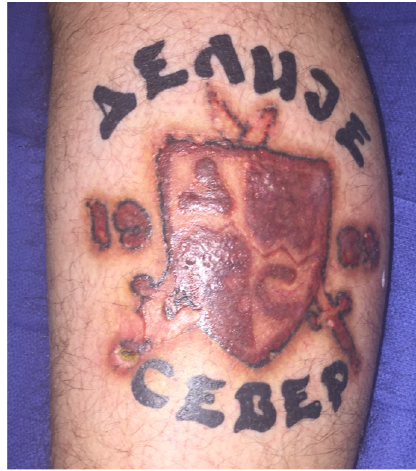
Figure 3. Eighteen months follow up with significant clinical improvement after management with six sessions of intra-lesional steroid injections and topical corticosteroid. The tattoo is no longer raised, scaly or pruritic. The tattoo is largely preserved with an acceptable aesthetic outcome.